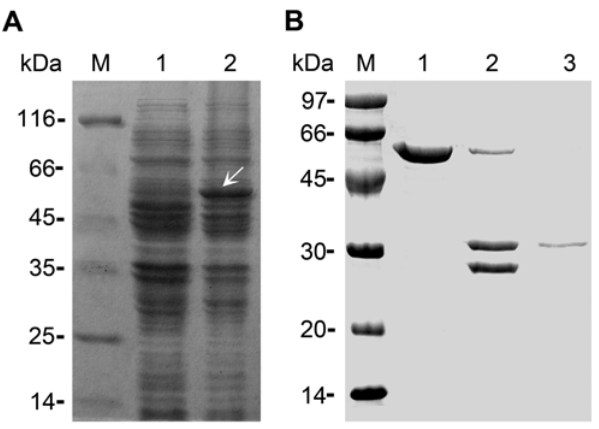
Figure 1. Purification of VER2 protein. (A) Induction of GST-VER2 recombinant protein in E. coli by use of IPTG. Lane 1, cell lysate before the addition of IPTG; Lane 2, cell lysate at 5 h after IPTG induction. The position of induced GST-VER2 is marked by an arrow. Lane M, molecular weight markers. (B) Purification of recombinant VER2 protein. Lane 1, the purified GST-VER2 fusion protein; Lane 2, thrombin digestion of GST-VER2 to GST and VER2; Lane 3, the purified VER2. Lane M, molecular weight markers. The gels were stained with coomassie brilliant blue.